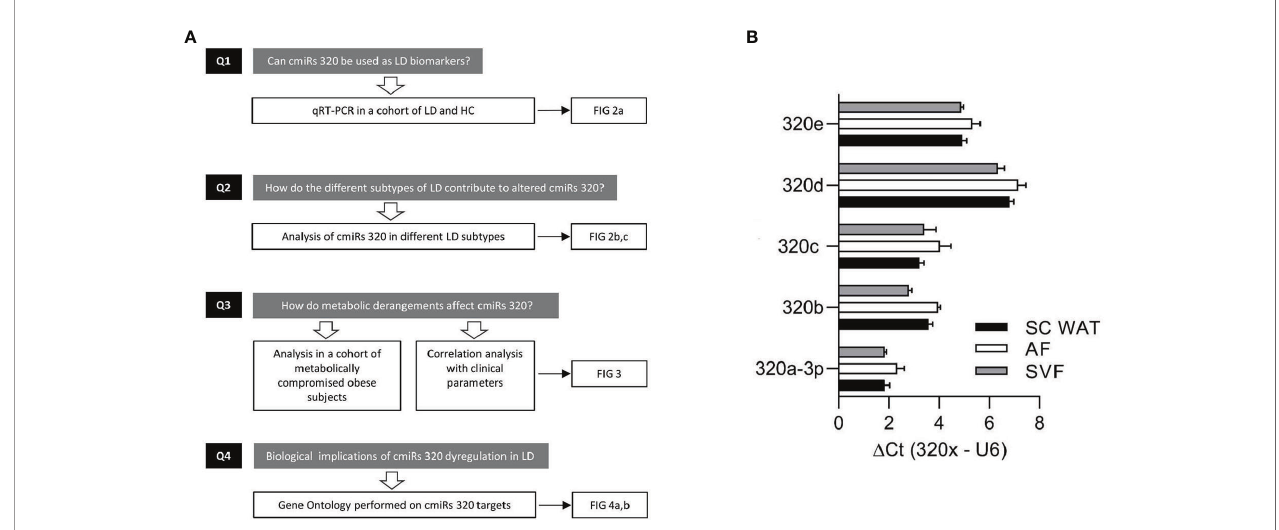
FIGURE 1 | Experimental design and discovery study. (A) Flowchart depicting the experimental design consisting in: quantitation of cmiRs-320 levels and further characterization steps as indicated. (B) Bar graphs of 320 family miRNAs in subcutaneous WAT and subfractions. Data are expressed as mean ± SEM for 3 independent